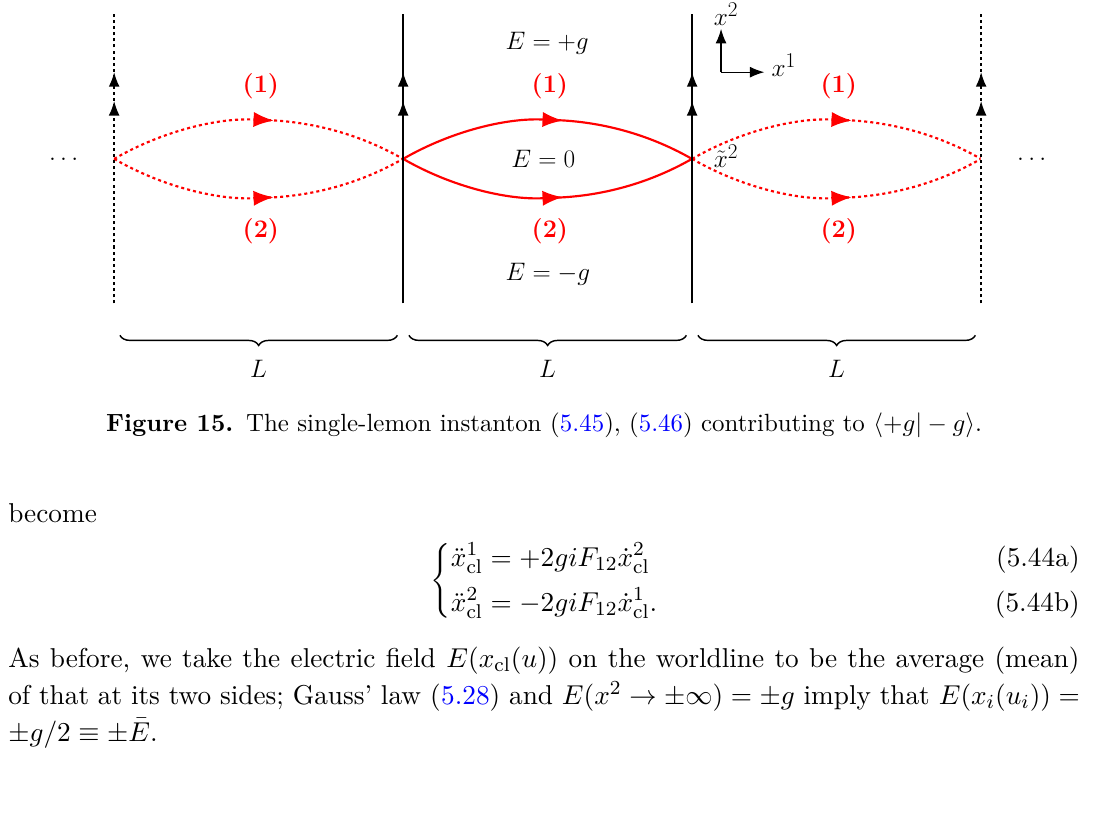
Figure 14. The continuum extrapolated ( N/ straight line instanton estimate (5.42) (curves) of the energy difference ∆ E and first excited states for background field α = 0 . 5 . Top panel: each color represents a fixed value of m/g ; bottom panel: each color represents a fixed value of mL .